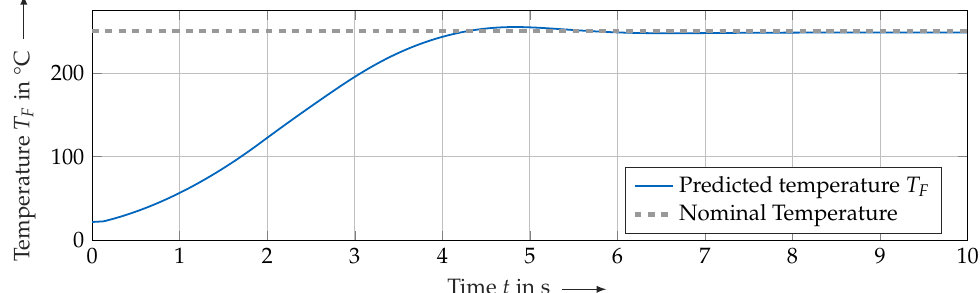
Figure 6. Temperature control simulation with the parameterized system and a constant torque of